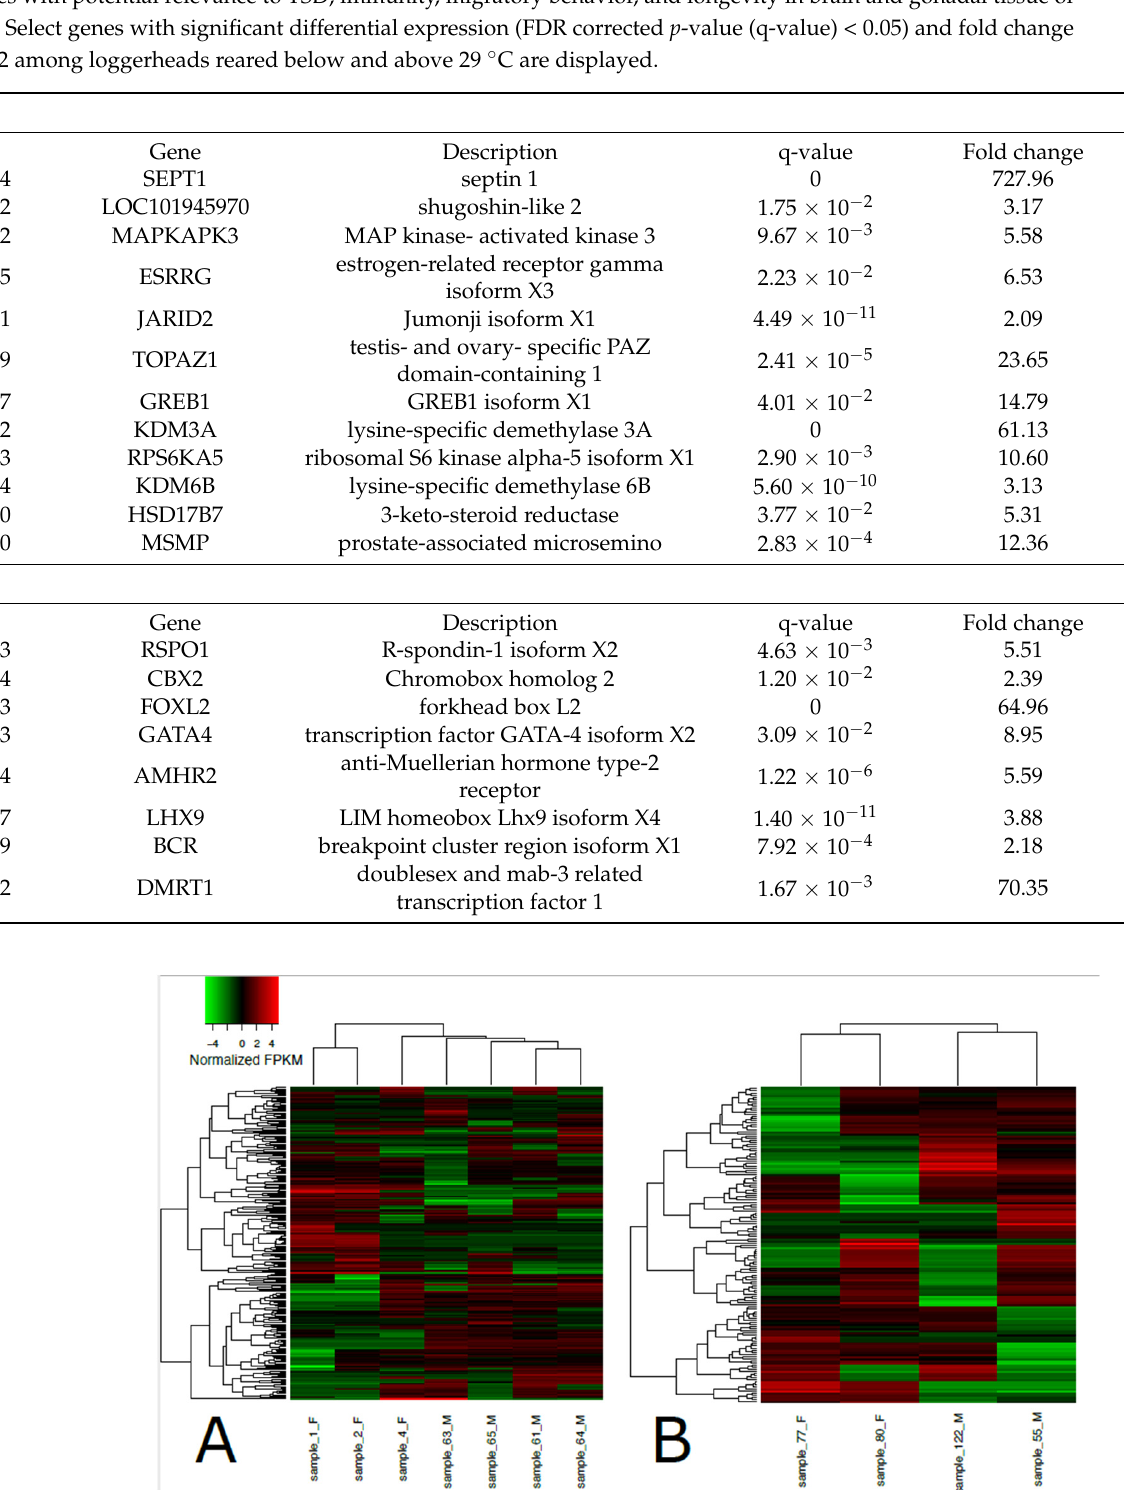
Figure 2. Heatmap of differentially expressed transcripts in loggerhead brain ( A ) and gonadal ( B ) tissue clustered by sex. Sex is indicated in sample names for females (F) and males (M). Significantly expressed transcripts (FDR < 0.001) with at least 4-fold differential expression are displayed in normalized FPKM values using the top 50 differential expression features within pairwise comparisons. Table 1. Raw reads retrieved per sample and number of reads aligned to assembled transcriptomes for loggerhead brain and gonadal tissues.